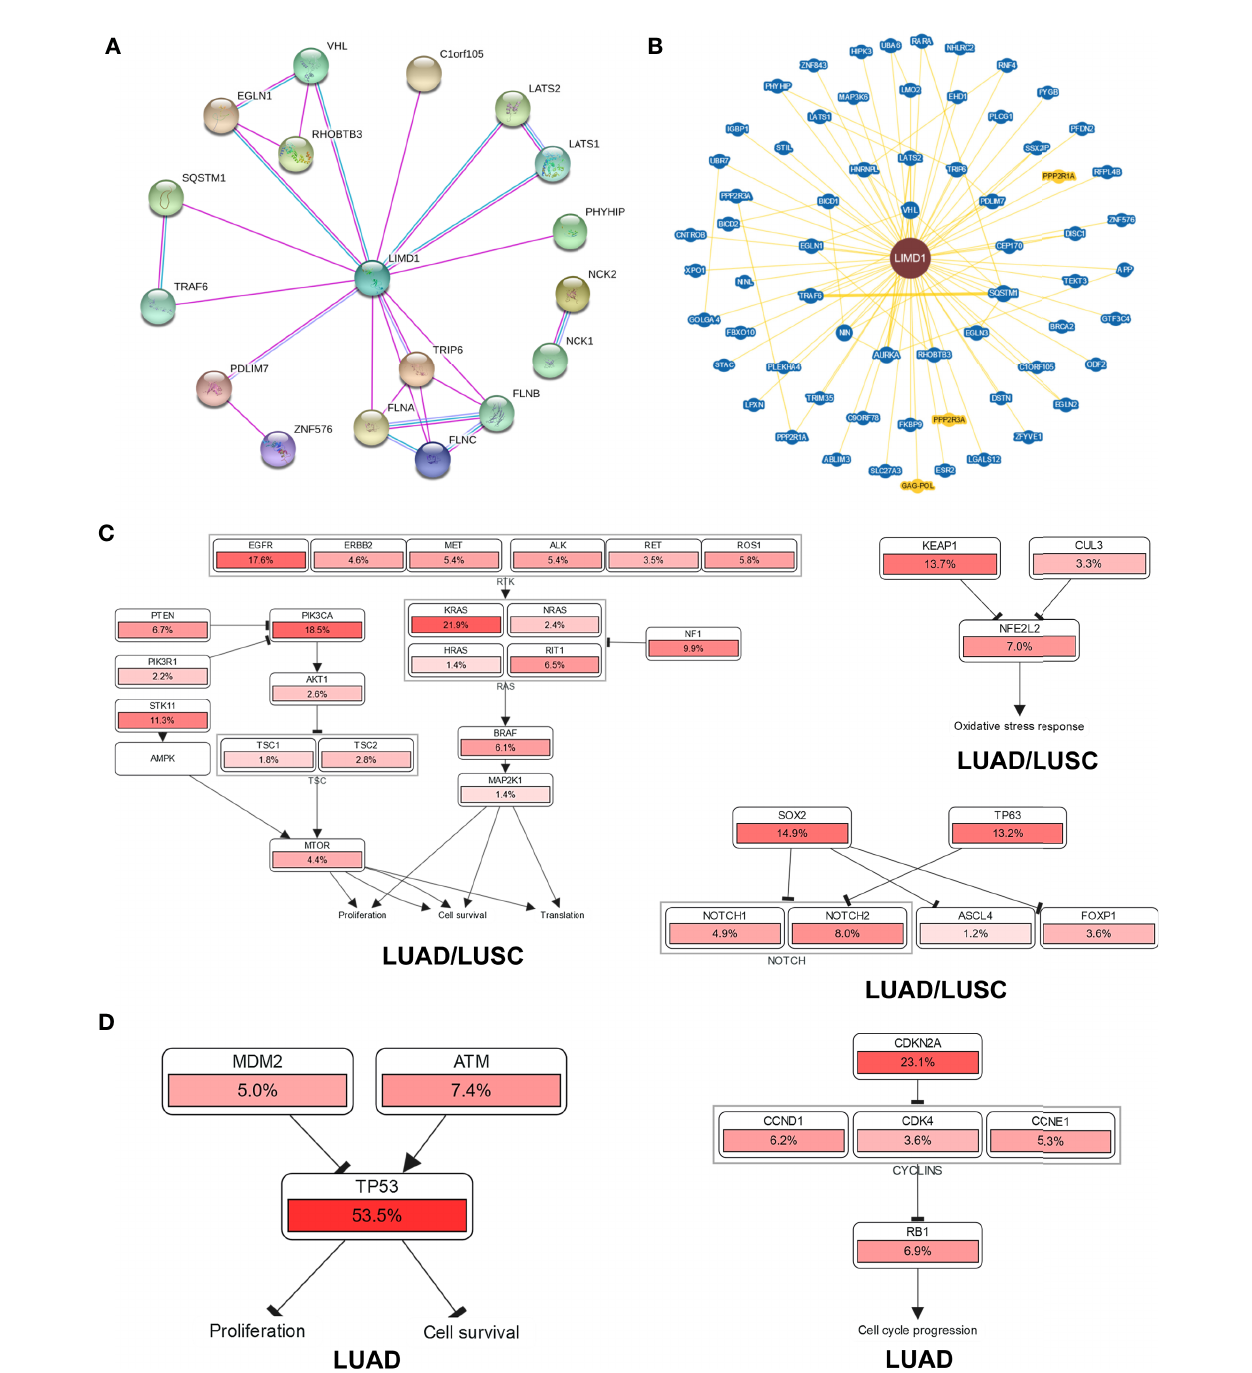
FIGURE 8 | Genome-wide interaction and pathway association of LIMD1 in NSCLC. (A) Known LIMD1 protein physical interaction network, as analyzed in STRING databases. Co-expression, textmining, neighborhood, and gene fusion were excluded in the settings. Green line: from curated databases; Pink line: Experimentally validated; Purple line: Proteins with homology. (B) Physical interactors of LIMD1 protein as identi fi ed in BioGRID with various databases from both high and low throughput assays. Blue: Associated protein from the same organism; Yellow: Associated protein from a different organism (PPP2R1A and PPP2R3A are from mouse, and GAG-POL from HIV). (C) The pathways that are deregulated in correlation with LIMD1 in both LUAD and LUSC. (D) The unique pathways that are deregulated in correlation with LIMD1 in LUAD. The deregulation of individual genes is shown in red. The more frequently a given gene is deregulated, the deeper red is